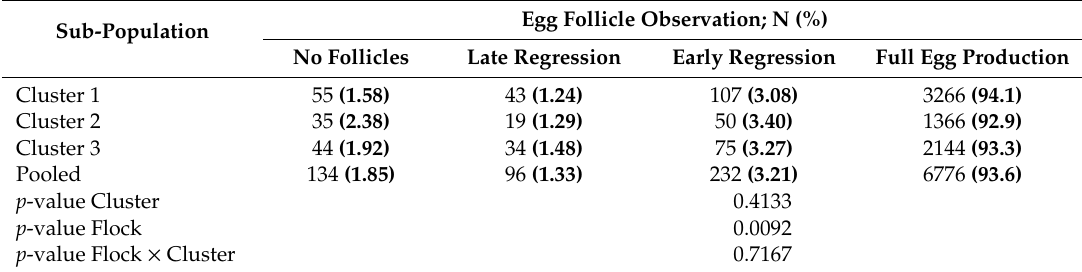
Table 4. The proportion of hens with di ff erent egg follicle scores of clusters 1, 2, and 3 in free-range laying hens at 74 weeks of age based on the K-means analysis.